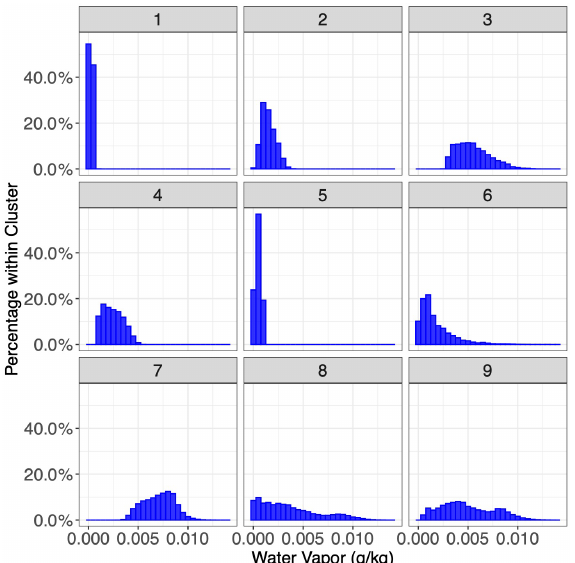
Figure 8. Histogram of Nature Run water vapor for each cluster identified by the Gaussian mixture model, applied to the testing set. Each sub-panel represents the cluster each point was assigned to.